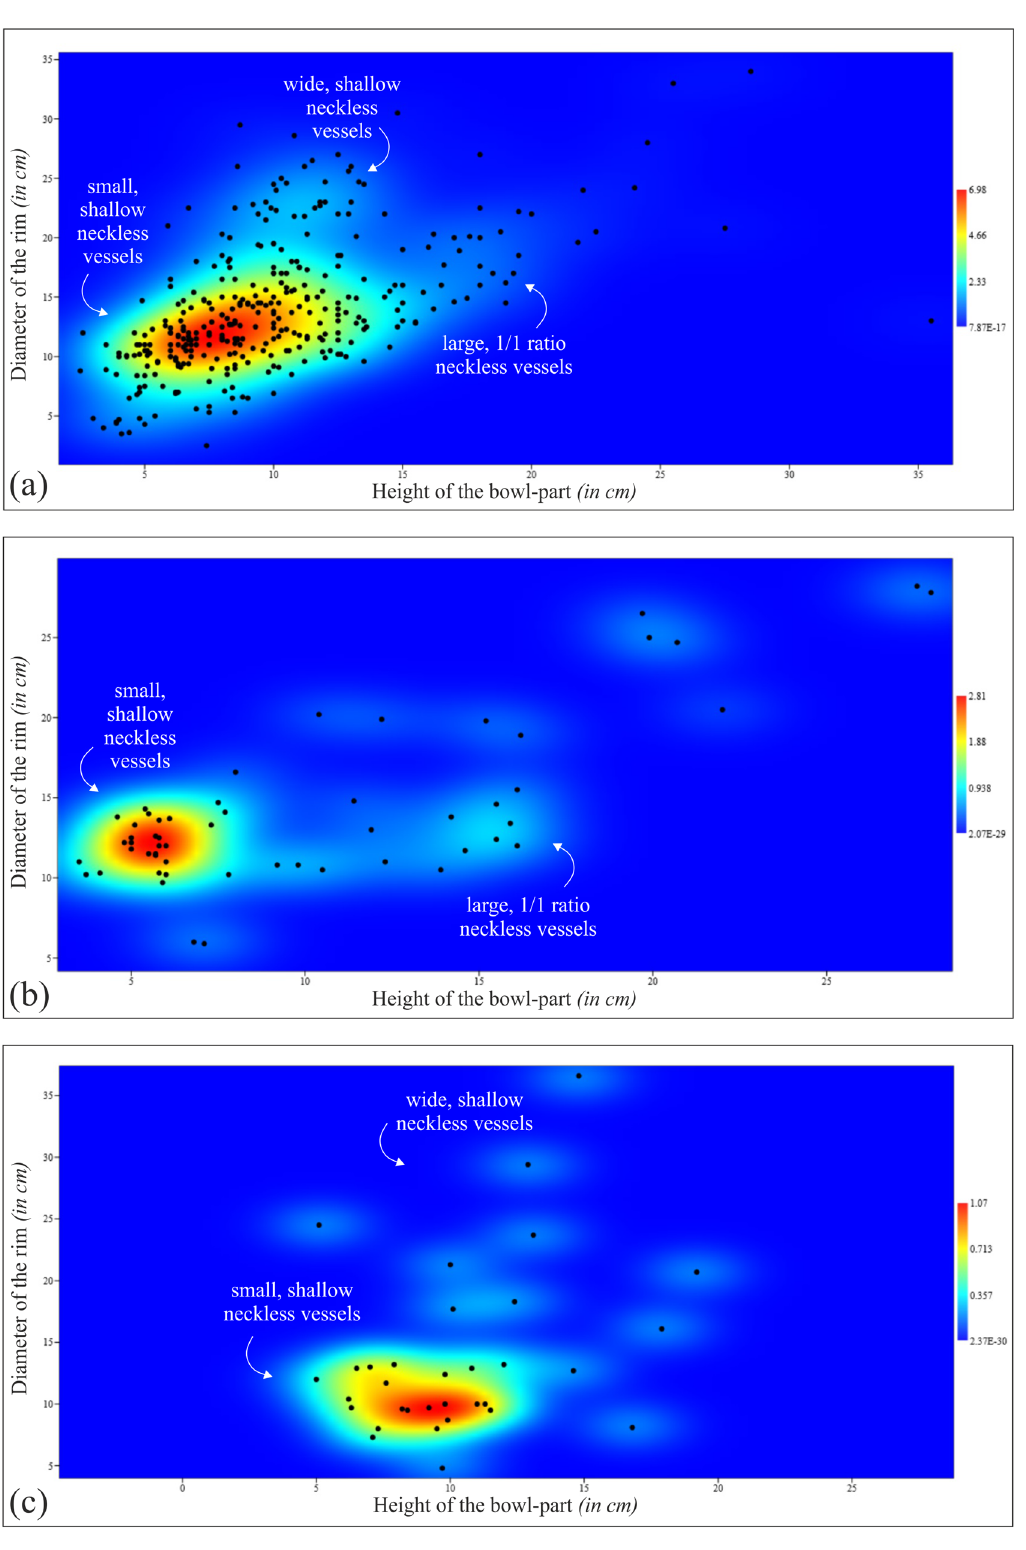
Figure 7: Kernel density plot of neckless vessels at: ( a ) Tiszapolgár - Basatanya; ( b ) Tiszavalk - Kenderföld; and ( c ) Polgár - Nagy - Kasziba and Tiszabábolna -